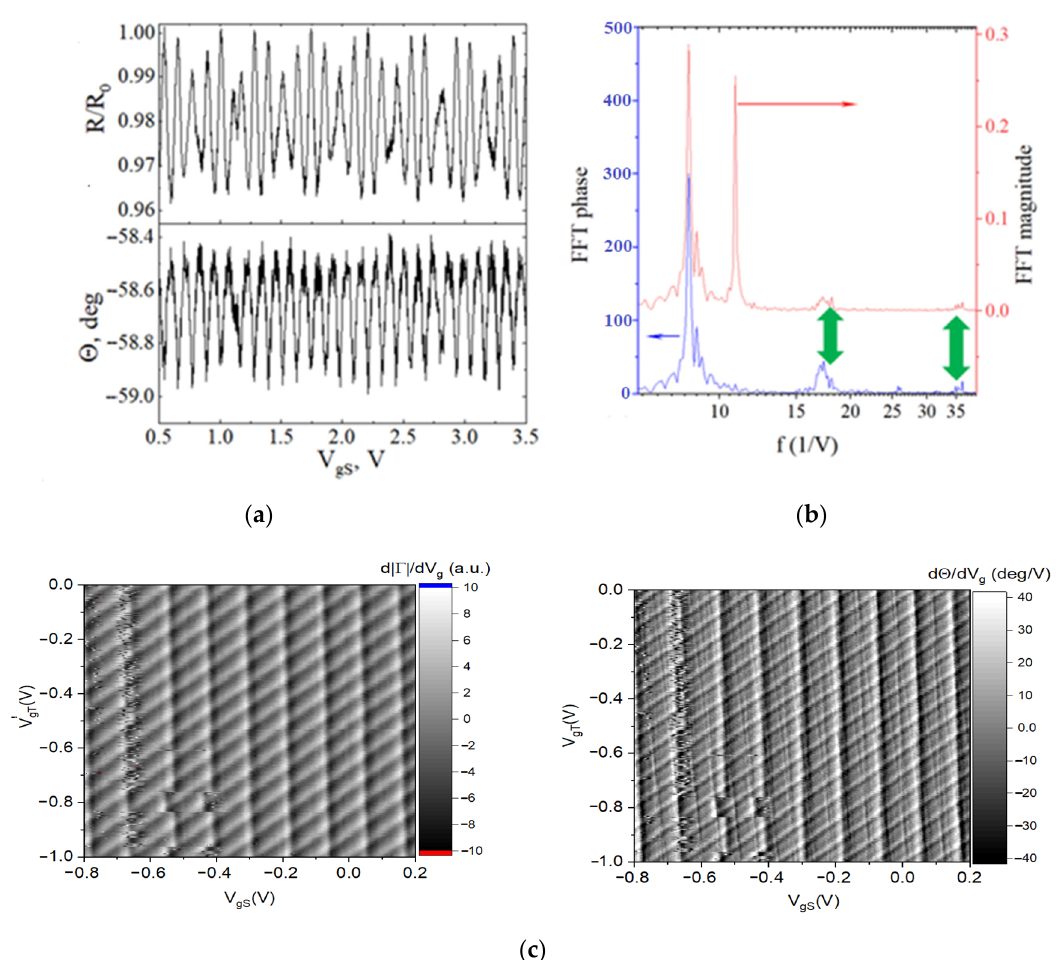
Figure 18. Experimental results from 4 SEBs and 2 DCD SETs obtained at T = 1.45 K ( a ) Oscillations of R and Θ as a function of the sensing gate, V gS . ( b ) Fast Fourier spectra of the magnitude and phase of the reflected signal over ± 4 V V gS range. Two lower frequency components in magnitude stem from the SETs, while smaller peaks marked by green arrows point to the 1st and 2nd harmonics of signals stemming from 4 SEBs charging. ( c ) 2D maps of dR / dV g and d Θ / dV g oscillations. Phase derivative plot reveals the presence of a much weaker signal (faint steep lines in d Θ / dV g map) that corresponds to charging in the SEBs. There is a visible random telegraph noise near V gS = − 0.62 V, likely due to random trap charging near the “fully floating “DCD